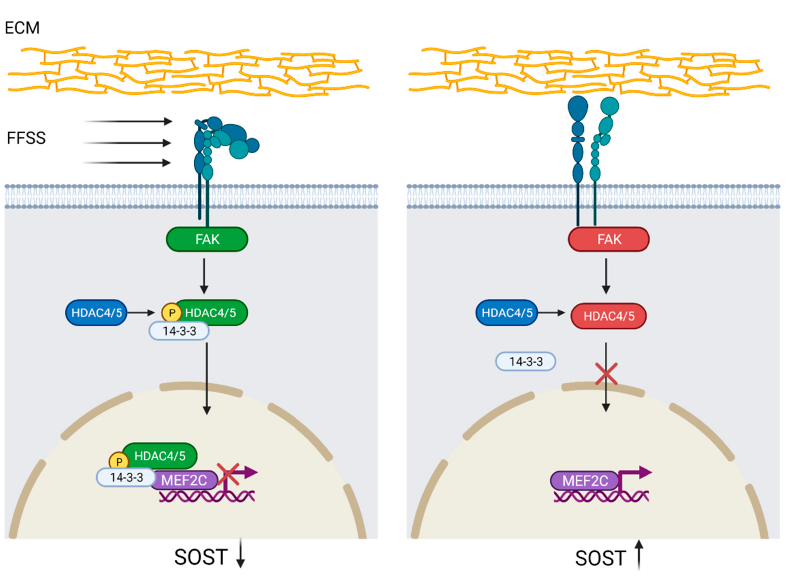
Figure 2. Regulation of SOST by histone deacetylase 4/5 (HDAC4/5) activation. Integrin- disintegration, due to fluid flow shear stress (FFSS) in the extracellular matrix (ECM), activates focal adhesion kinase (FAK), which subsequently phosphorylates HDAC4/5. Phosphorylated HDAC4/5 binds to protein 14-3-3 leading to nuclear translocation where, by binding to myocyte-specific enhancer factor 2C (MEF2C) and histone deacetylation at the evolutionarily conserved region 5 (ECR5) site, prevents SOST expression. Lack of FFSS precludes HDAC4/5 phosphorylation and thus nuclear translocation, which promotes MEF2C binding to ECR5 and SOST upregulation. SOST downreg- ulation = black arrow down; SOST upregulation = black arrow up. Created with BioRender.com, accessed on 15 February 2022.